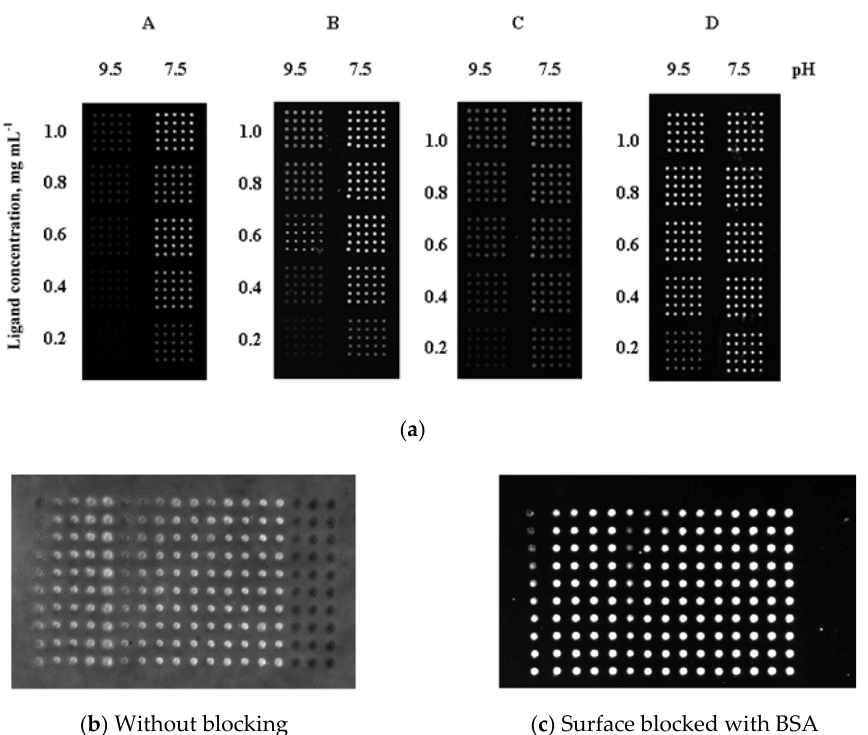
Figure 9. Dependence of analytical signal on pH of probe immobilization ( a ) (( A ) poly(GMA-co-EDMA), ( B ) poly(GMA-co-GDMA), ( C ) poly(CEMA-co-HEMA-co-EDMA), ( D ) poly(CEMA-co- EDMA) layers) and effect of surface blocking ( b , c ) (poly(GMA-co-EDMA) layers). Reprinted with permission of Elsevier from [60].